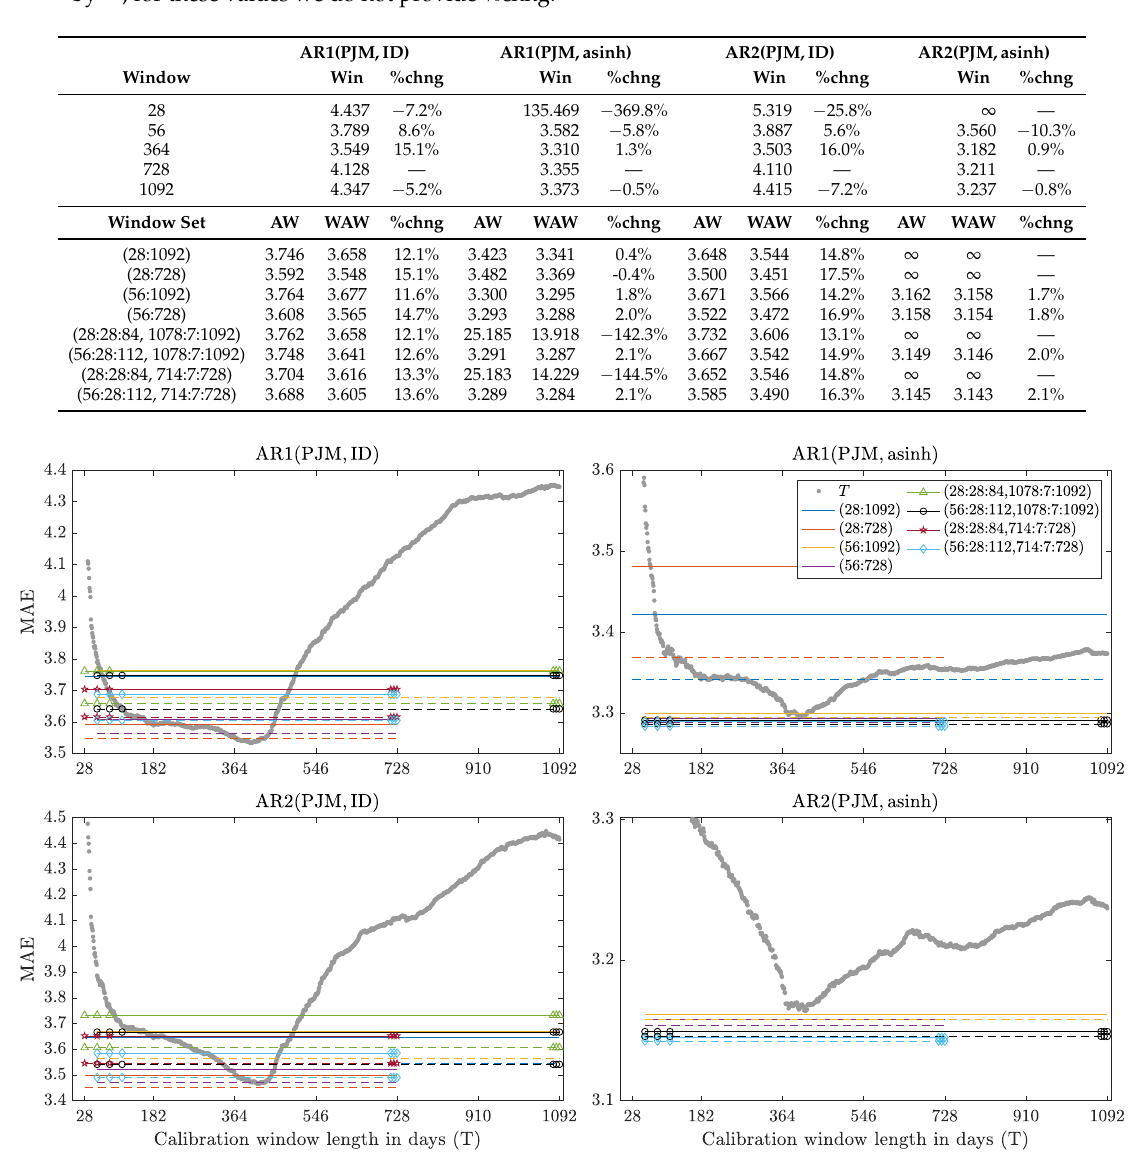
Table 3. Mean absolute errors (MAE) of the AR1 and AR2 models fitted to ID - or asinh -transformed PJM data for selected windows ( T ) and window sets ( T ). Relative improvements (%chng) of the Win ( T ) and WAW ( T ) forecasts with respect to Win (728) are also reported. MAEs in excess of 10 10 are denoted by ∞ ; for these values we do not provide %chng.